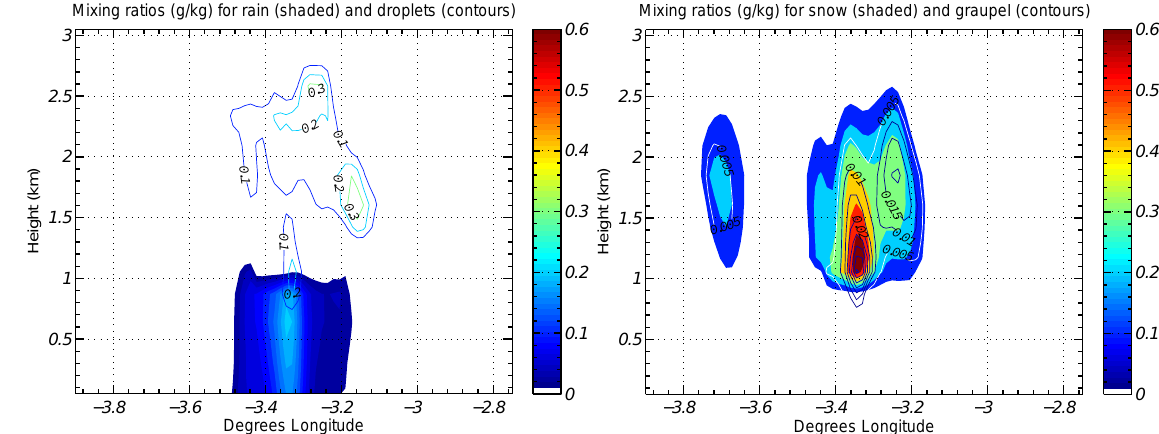
Fig. 9. Meridional cross-sections from model output at 51 ◦ N at time 12:00UTC. Left: liquid mixing ratios (rain and droplet categories); right : ice mixing ratios (snow and graupel categories). Plots are in units of gkg − 1